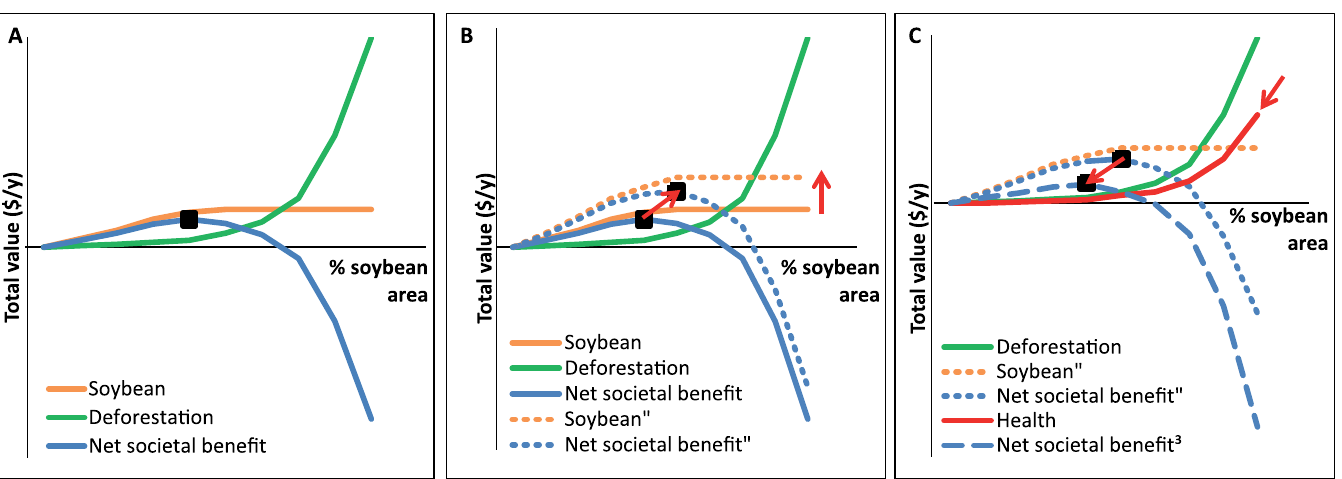
Fig 7. A: Balance between soybean income ( ‘ Soybean ’ ) and environmental damage from deforestation and grassland conversion ( ‘ Deforestation ’ ). The optimal trade-off between soybean expansion and deforestation is given by the maximum net societal benefit (black square), i.e. soybean income corrected for the cost of deforestation and grassland conversion. B: Consequences of increasing soybean income e.g. due to a population increase (Soybean ” and Net societal benefit “ ). C: Consequences of taking into account the health cost of increasing meat consumption (Health cost and Net societal benefit 3 ).